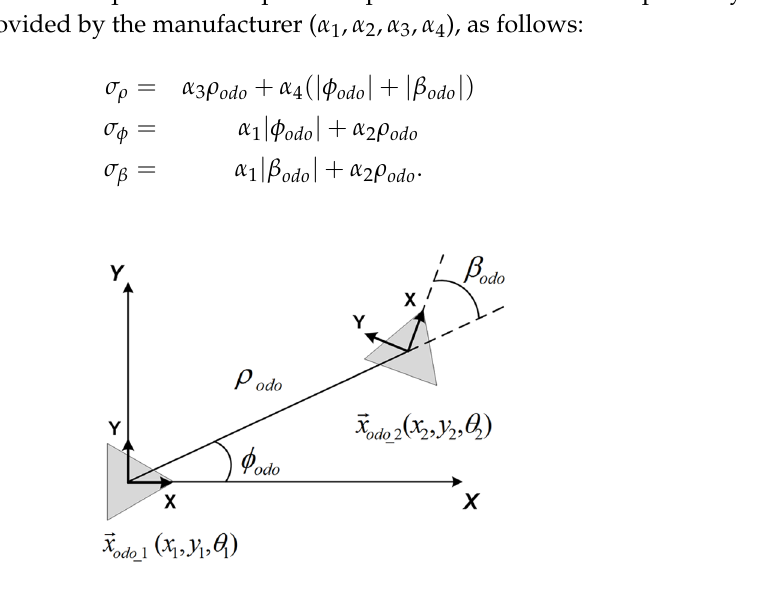
Figure 4. Odometer